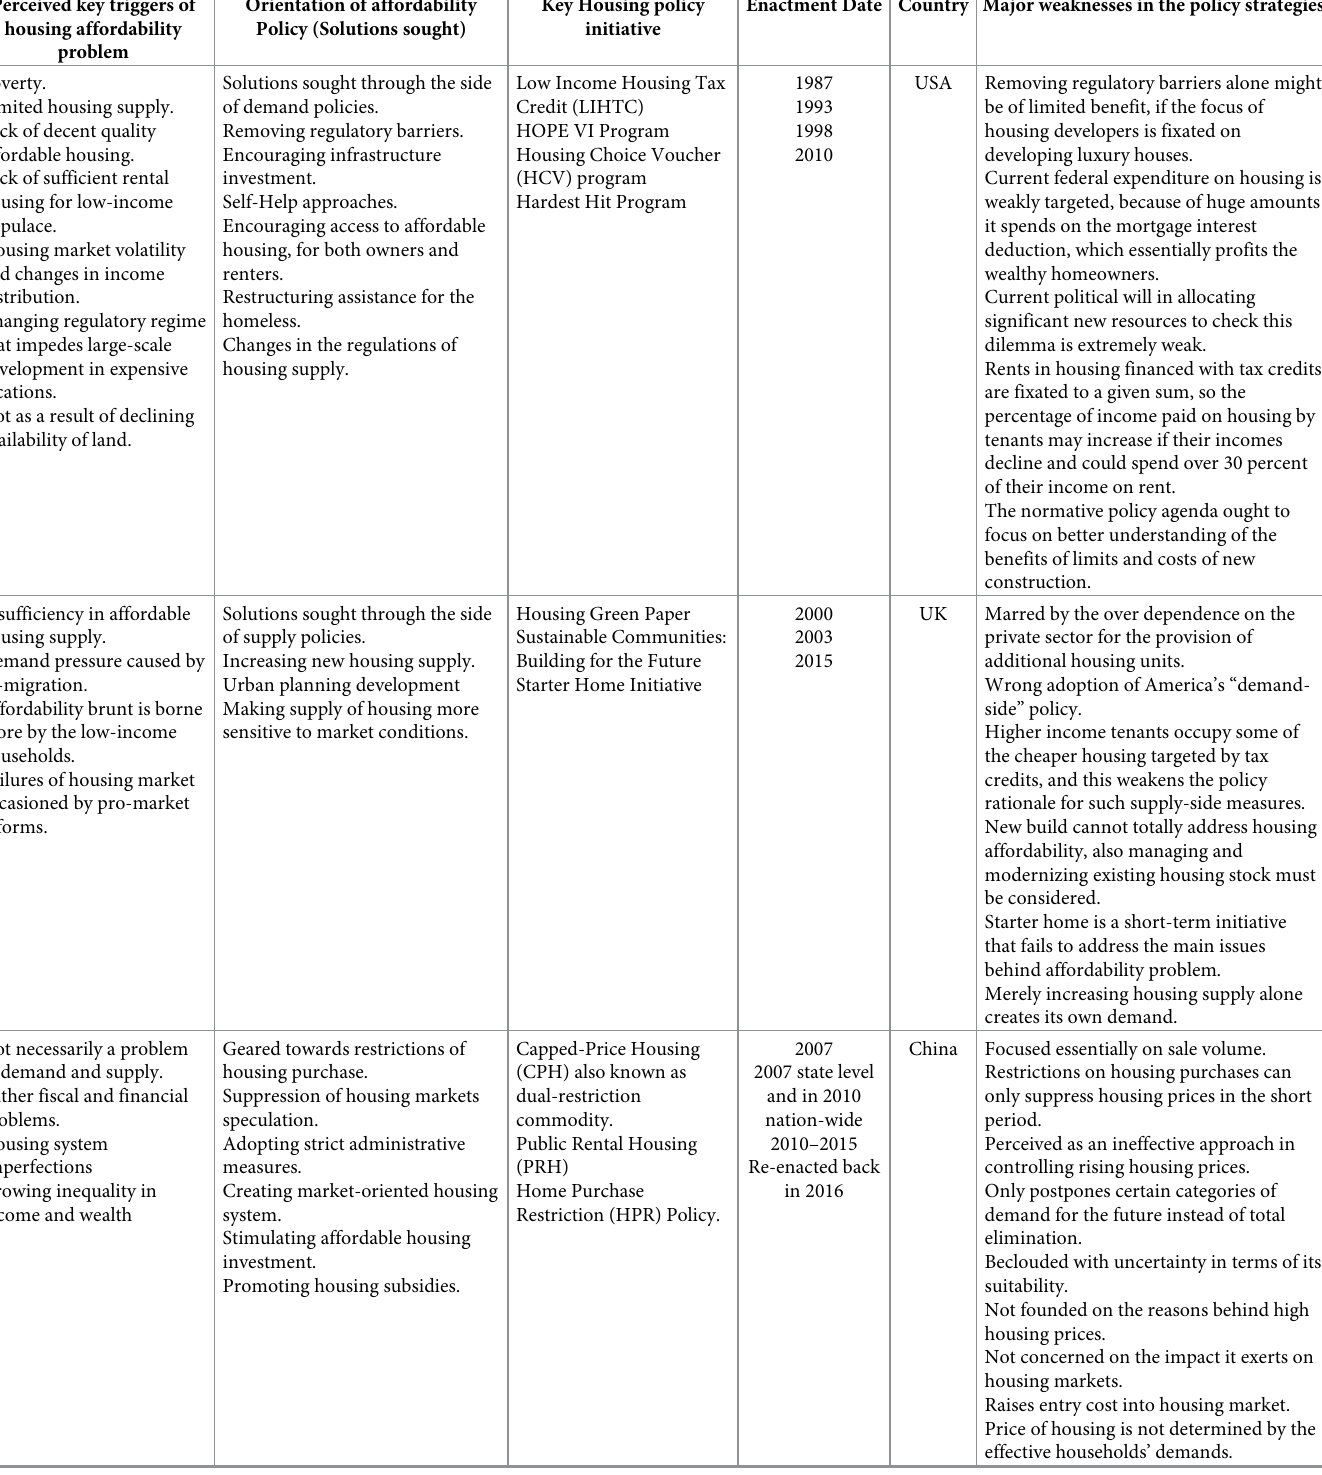
Table 2. Summary of key policy responses of selected countries and their attempts in addressing worsening housing affordability problem. Perceived key triggers of housing